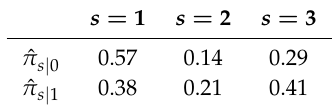
Table 4. Estimated initial probabilities for each